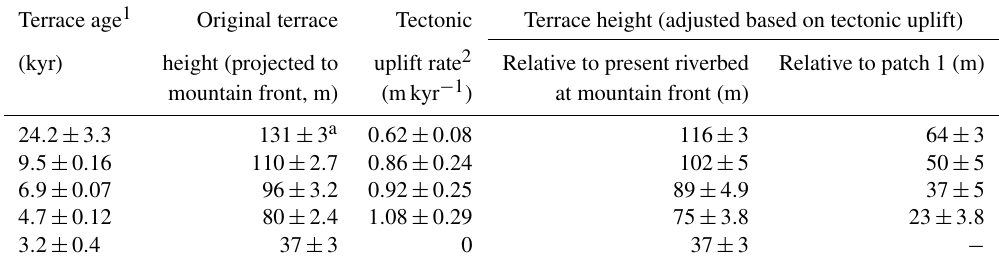
Table 4. Terrace ages and relative